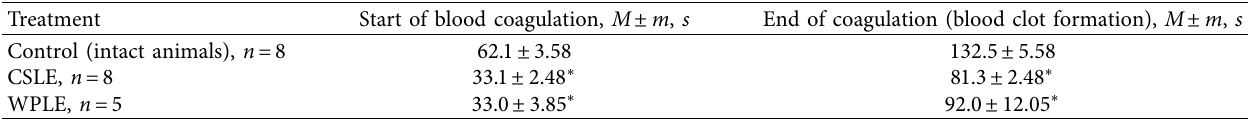
Table 5: Effect of CSLE on blood clotting time in white